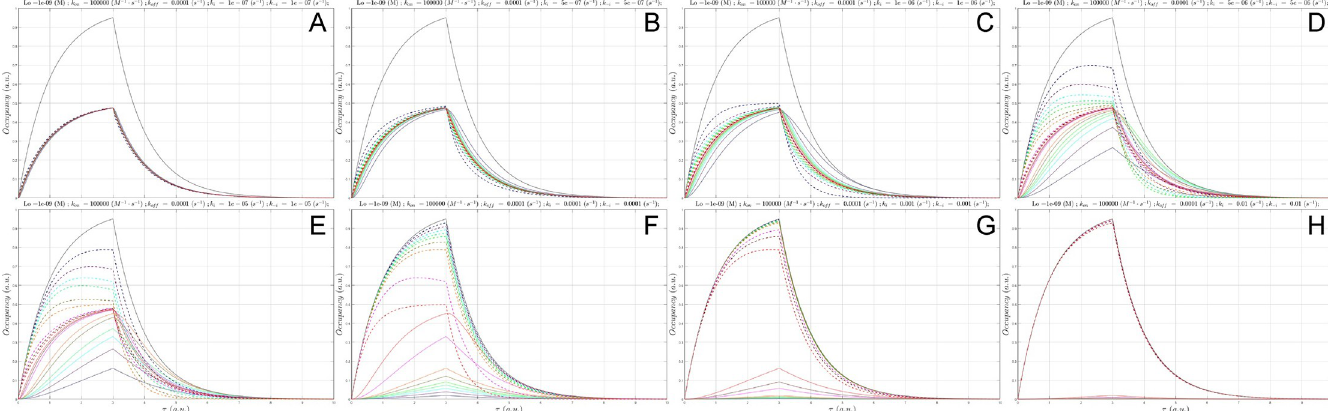
Fig 9. (A) Plot of B (solid lines color-coded from blue to red as a function of increasing k on ), and B free ( τ ) (dotted lines color coded the same as c ( τ )). c ( τ ) diverges slightly from SSO at k on = 1x10 3 M -1 s -1 . (B) Same as A, except Λ = 1,667 hr ( k (D) Same as A, except Λ = 167 hr ( k except Λ = 8.3 hr ( k min ( k i = k − i = 1x10 -2 s -1 , k